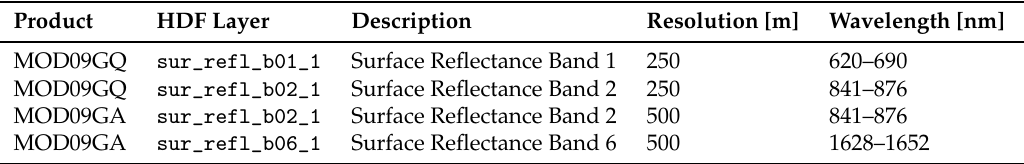
Table 2. MODIS Products Used in the DFHI Algorithm.